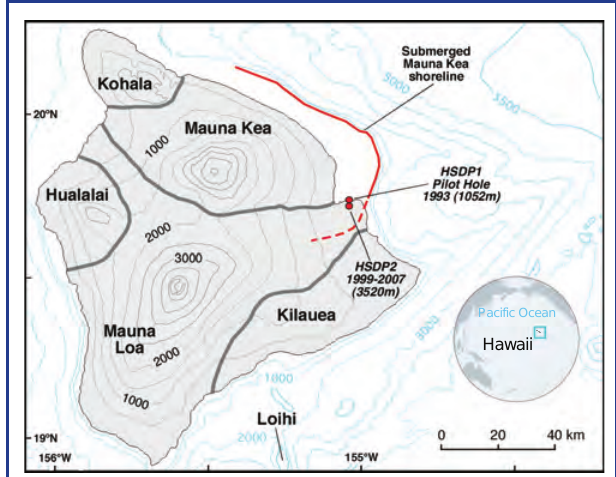
Figure 1. Map showing the boundaries of the major volcanoes of the island of Hawaii and the locations of the HSDP pilot hole drilled in 1993, and the deep hole drilled in 1999 and 2004–2007. The red line shows the approximate location of the shoreline of Mauna Kea when it reached its maximum extent above sea level, at the end of the shield-building stage about 150,000 years ago (see Fig. 6). Subsequently, subsidence has moved the shoreline 10–20 km closer to the volcano